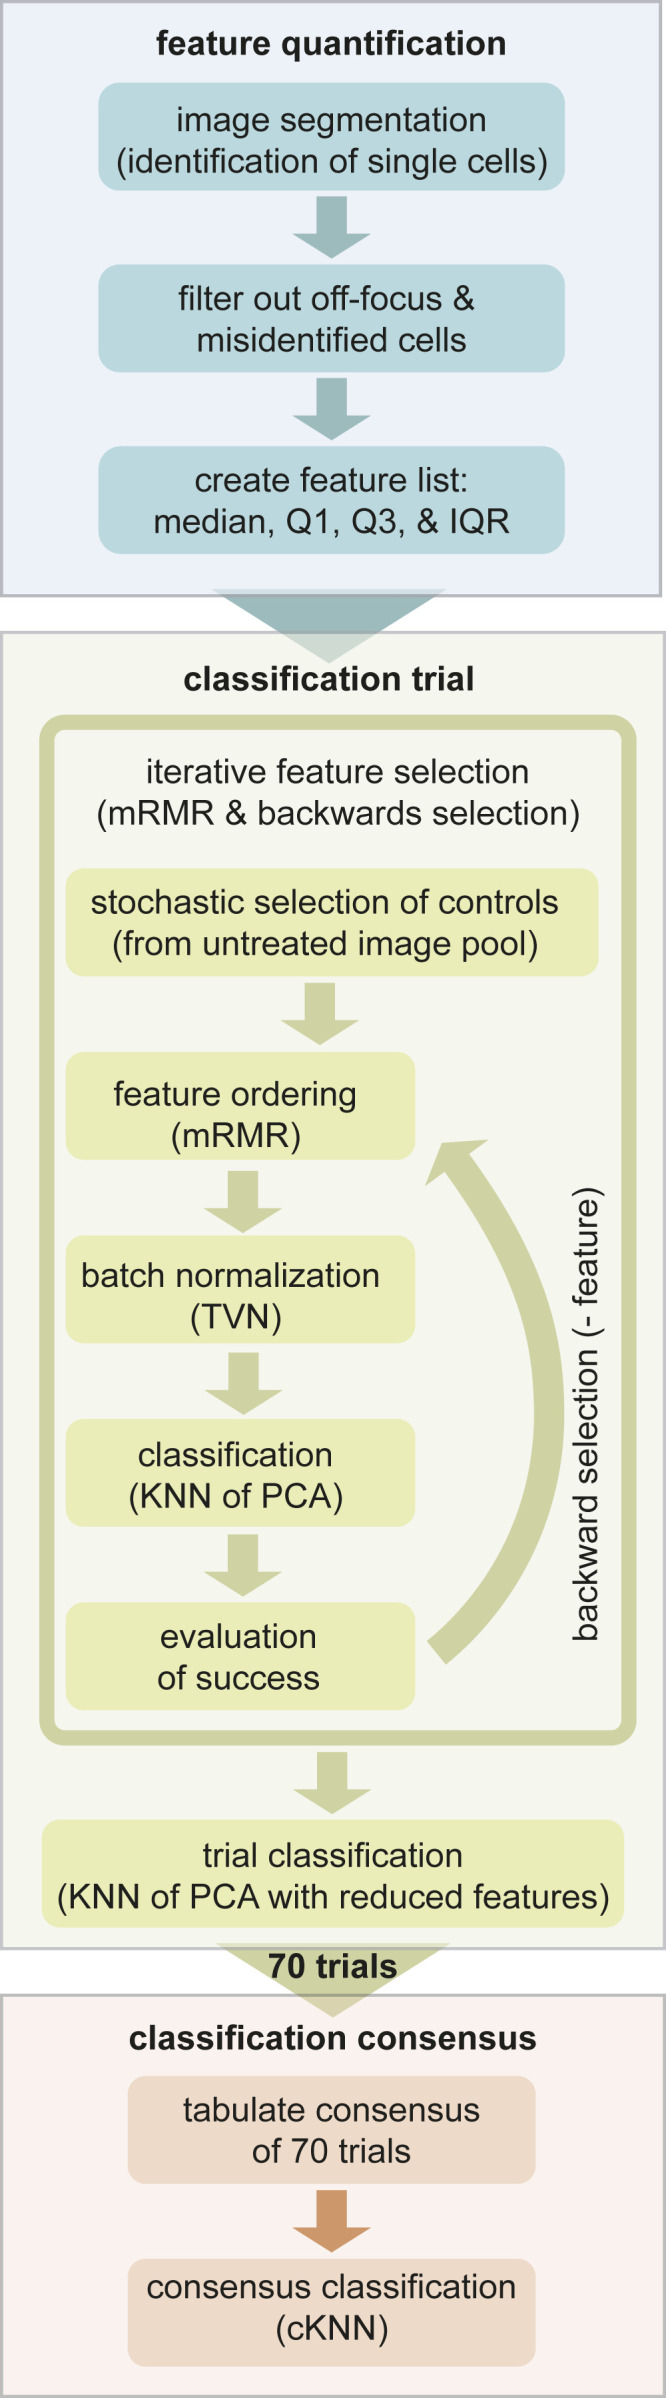
Computational pipeline for MorphEUS. The MorphEUS pipeline is composed of three steps: feature quantification (blue), classification trials (green), and classification consensus (orange). The main components of each step are highlighted as boxes within each of the three groups. A detailed description of each step is described in Materials and Methods.